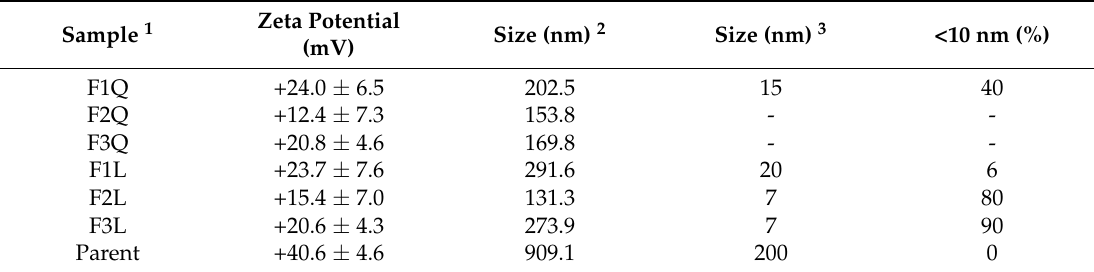
1 FiQ: Fractions obtained by depolymerization with chitosanase; FiL: Fractions obtained by depolymerization with lysozyme. 2 Data determined from dynamic light scattering measurement. 3 Data determined from transmission electron microscopy